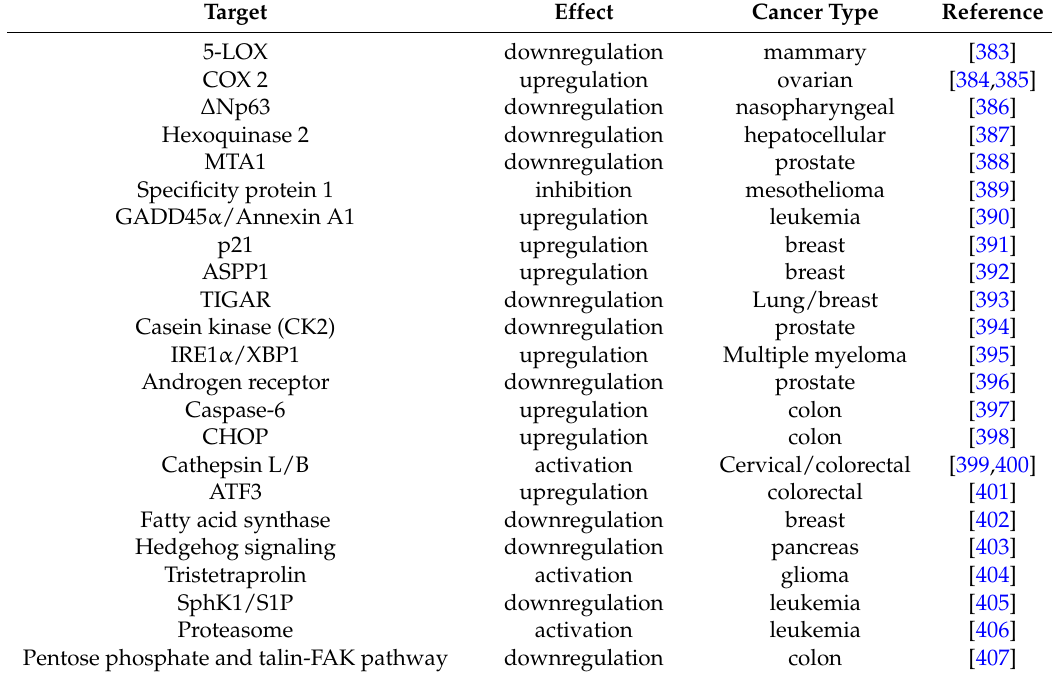
Table 5. Others examples of apoptotic targets for